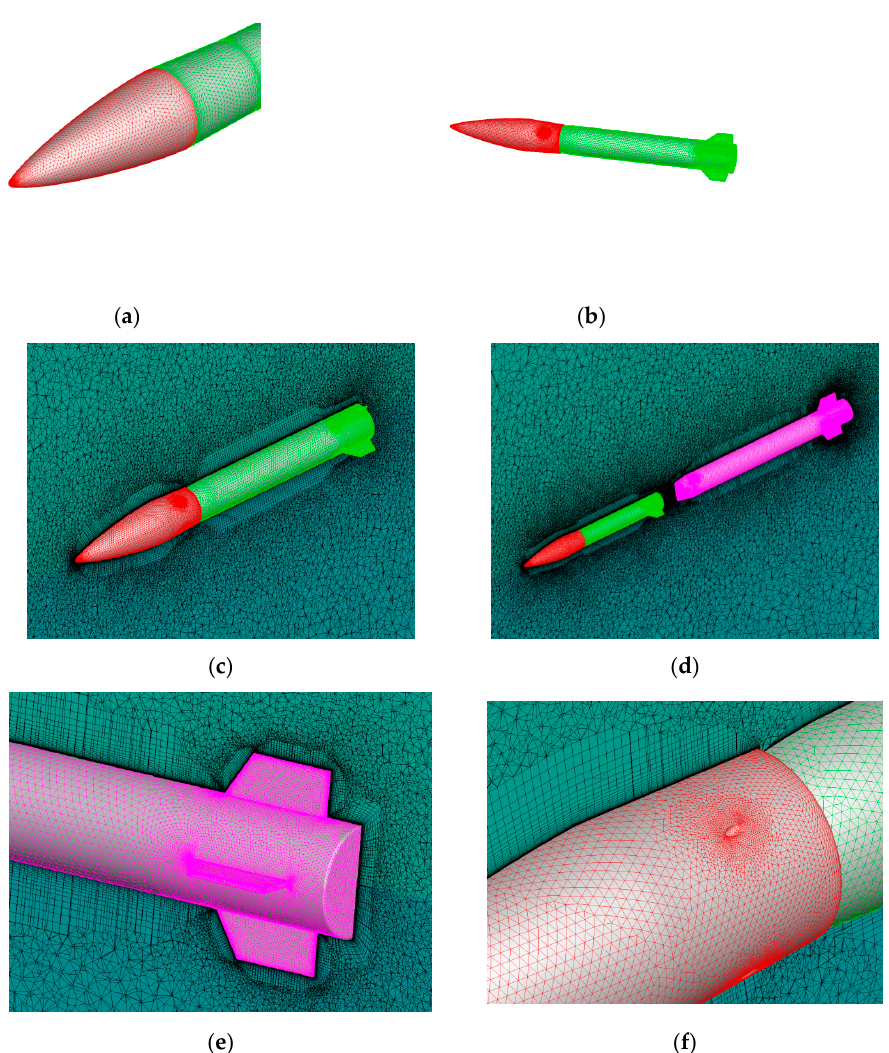
Figure 3. ( a )Fairing-area grid; ( b ) rudder-wing grid; ( c ) boundary-layer mesh; ( d ) symmetrical-plane mesh; ( e ) the grid near the rudder surface; ( f ) the grid near the nozzle.